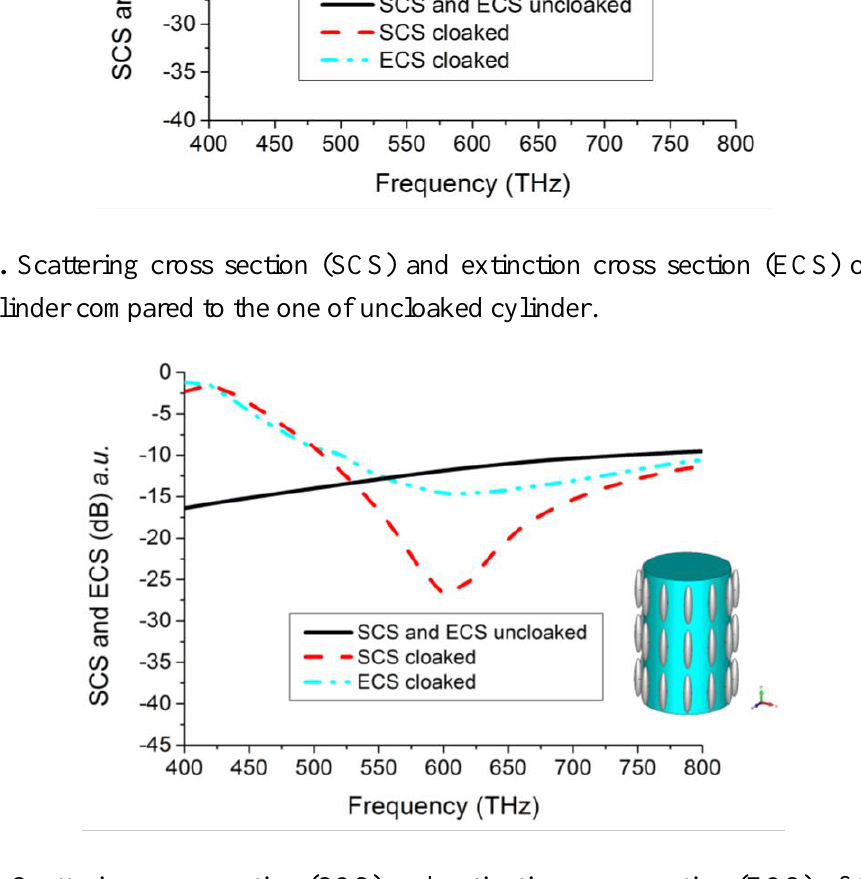
Figure 7. Scattering cross section (SCS) and extinction cross section (ECS) of the second coated cylinder compared to the one of uncloaked